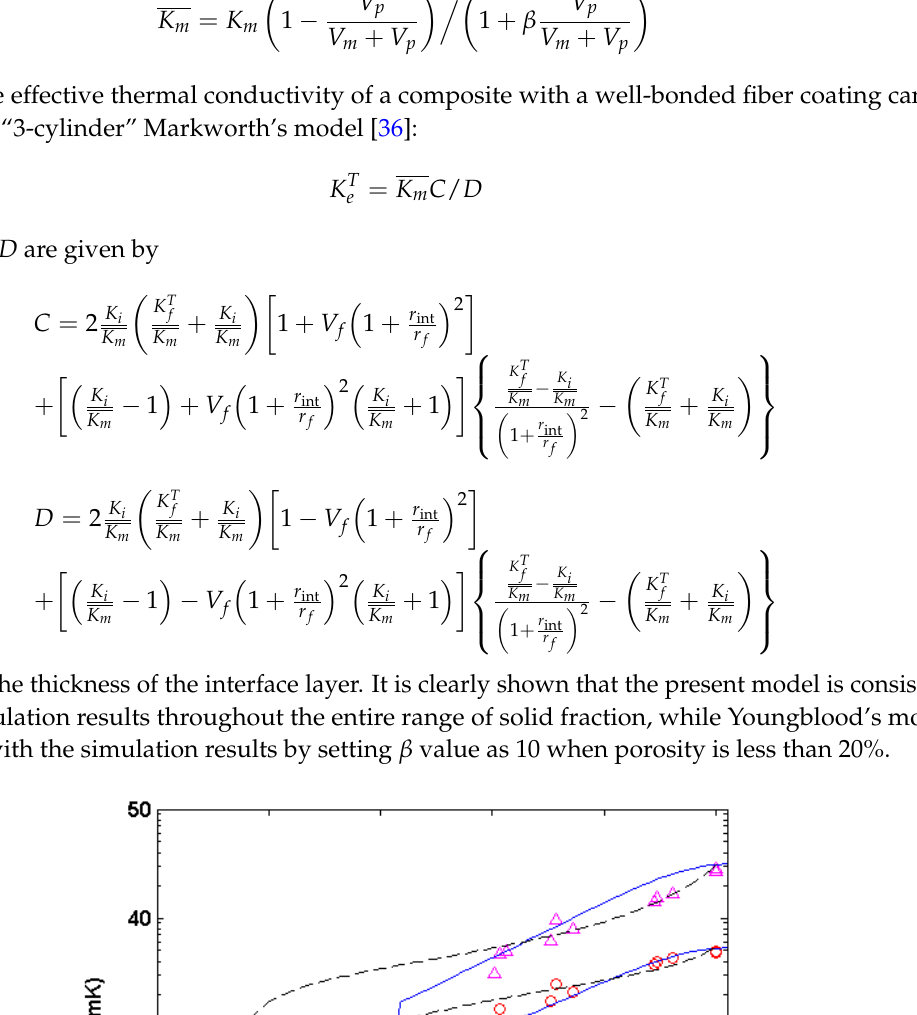
T K = 1 W · m − 1 · K − 1 , = 1 W·m − 1 ·K − 1 , K i = 40 f f